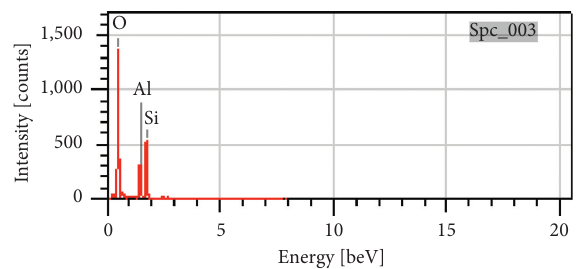
Figure 4: EDX diagram of Safi clay. Table 3: Elemental analysis of the clay surface.